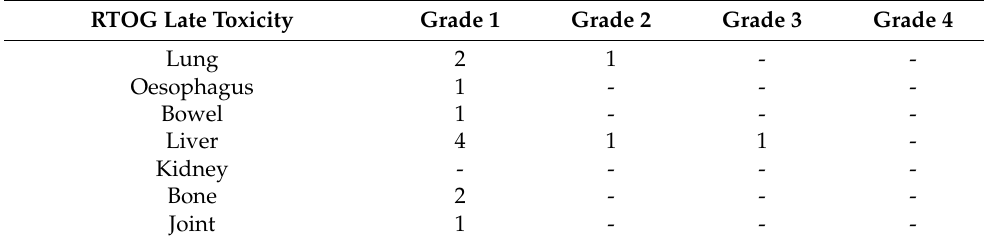
Table 4. RTOG late toxicity (>3 months after treatment). A patient may present several